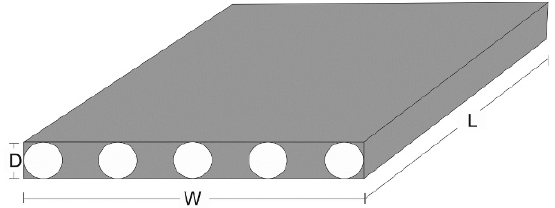
Figure 2. Schematic representation of heat exchanger composed of tubes with constant